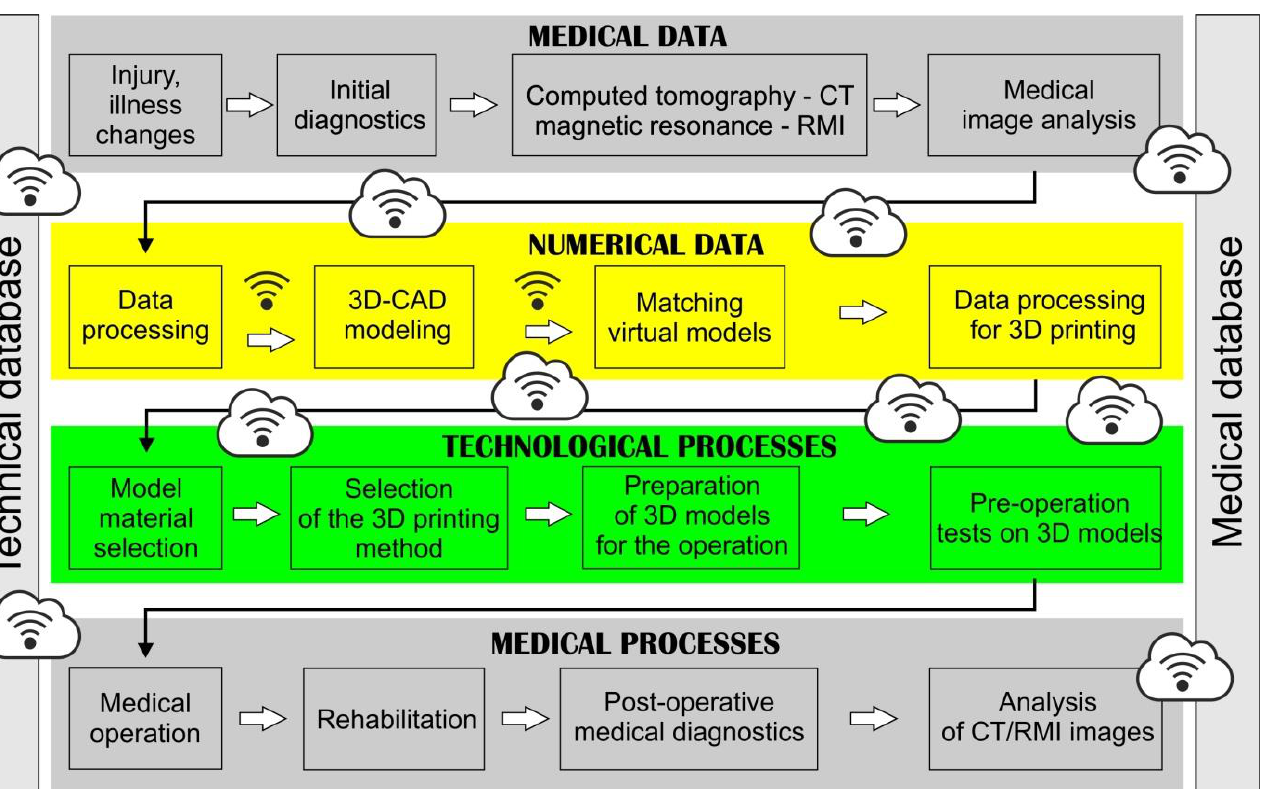
Figure 1. Diagram of integration of medical and technological systems using numerical data flow based on Industry 4.0 tools.